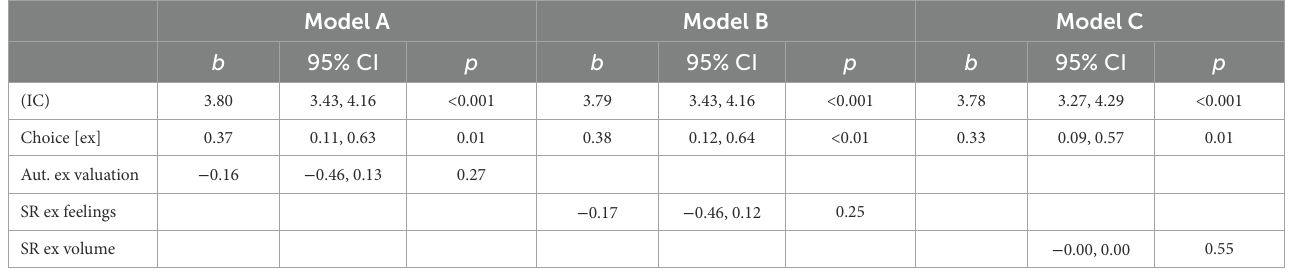
TABLE 2 Predicting exercise fixations with automatic valuation of exercise (Model A), self-reported feelings towards exercise (Model B) and self-reported exercise behavior (Model C) when making exercise-related choices.